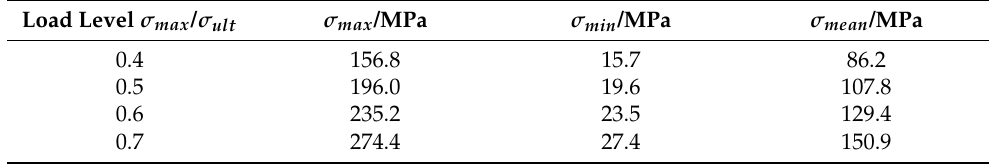
Table 5. Load levels and stress values for σ ult = 392 MPa and R = 0.1 [52].